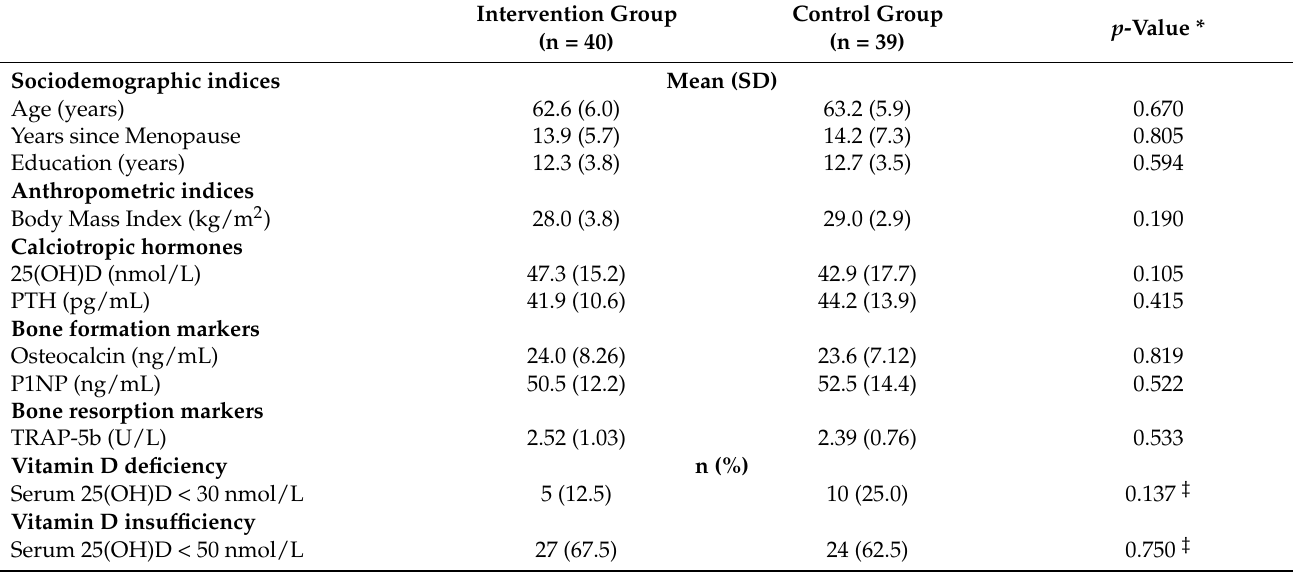
Table 1. Baseline descriptive characteristics of study participants completing the trial presented by